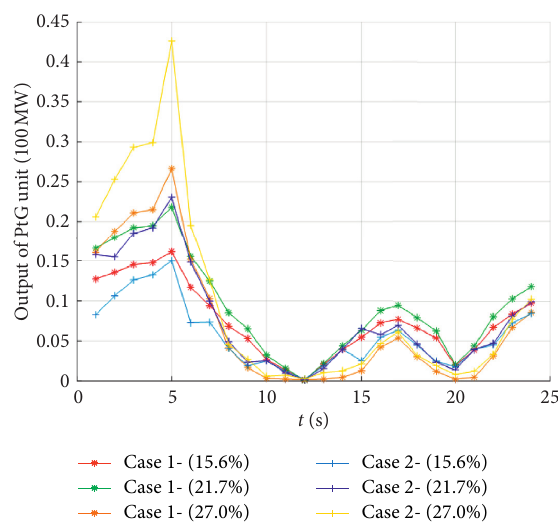
Figure 4: Comparison of the output of the PtG unit in two cases under different wind penetration rates.